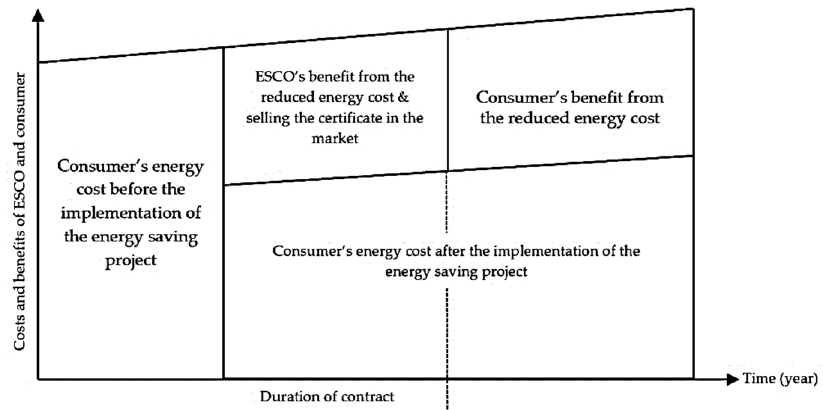
Figure 2. The benefits of Energy Service Company (ESCO) and energy consumer from energy reduced cost and certificates sale [20].